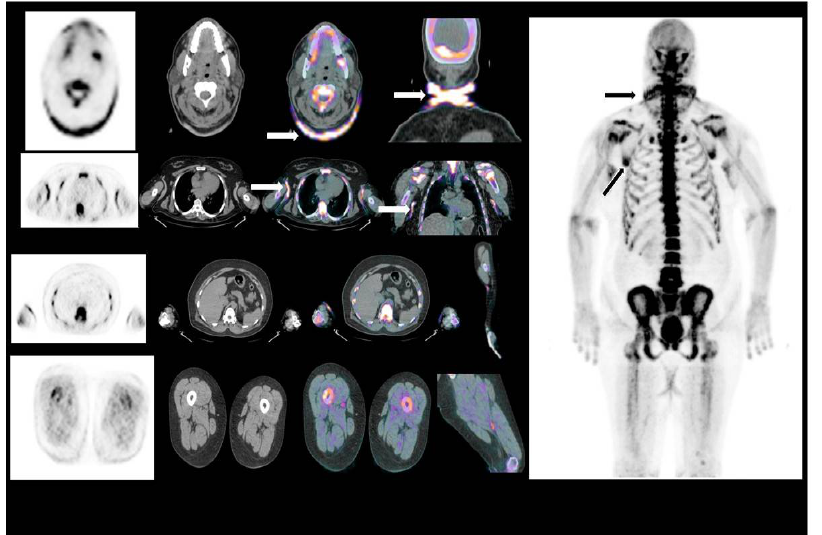
Figure 3. The 18-F-Na uptake in diseased skin at the level of the neck and axillae (arrows) on PET/CT